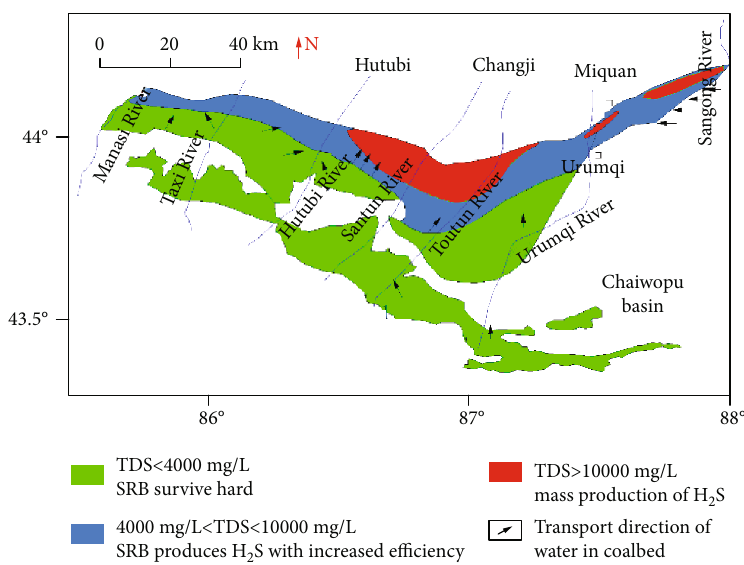
Figure 4: TDS distribution of groundwater and characteristics of SRB propagation and H